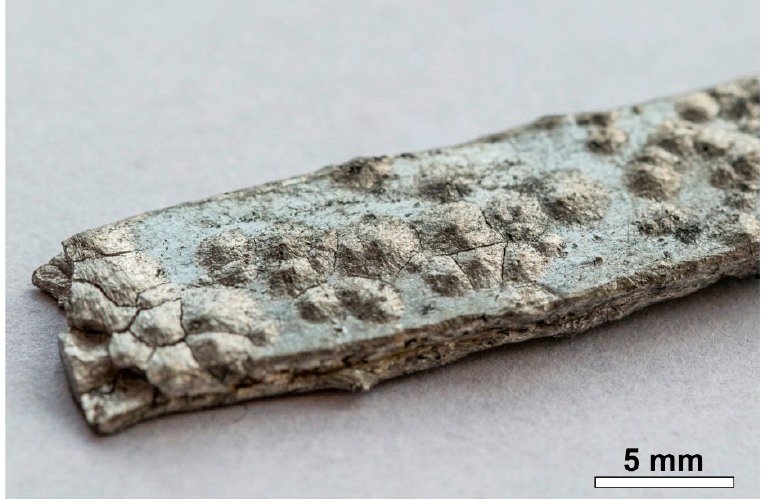
Figure 1. Tin pest warts and cracks on the surface of a tin solder bar; decomposition has already started at the ends of the bar.